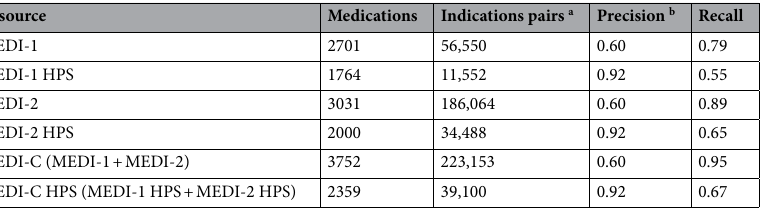
Table 3. Estimated precision and recall of MEDI-1 and MEDI-2. a Indication pairs for MEDI-2 include both ICD-9-CM indications and ICD-10-CM indications, which may include some overlap. b Estimated precision for MEDI-1 and MEDI-1-HPS from Wei et al. 20